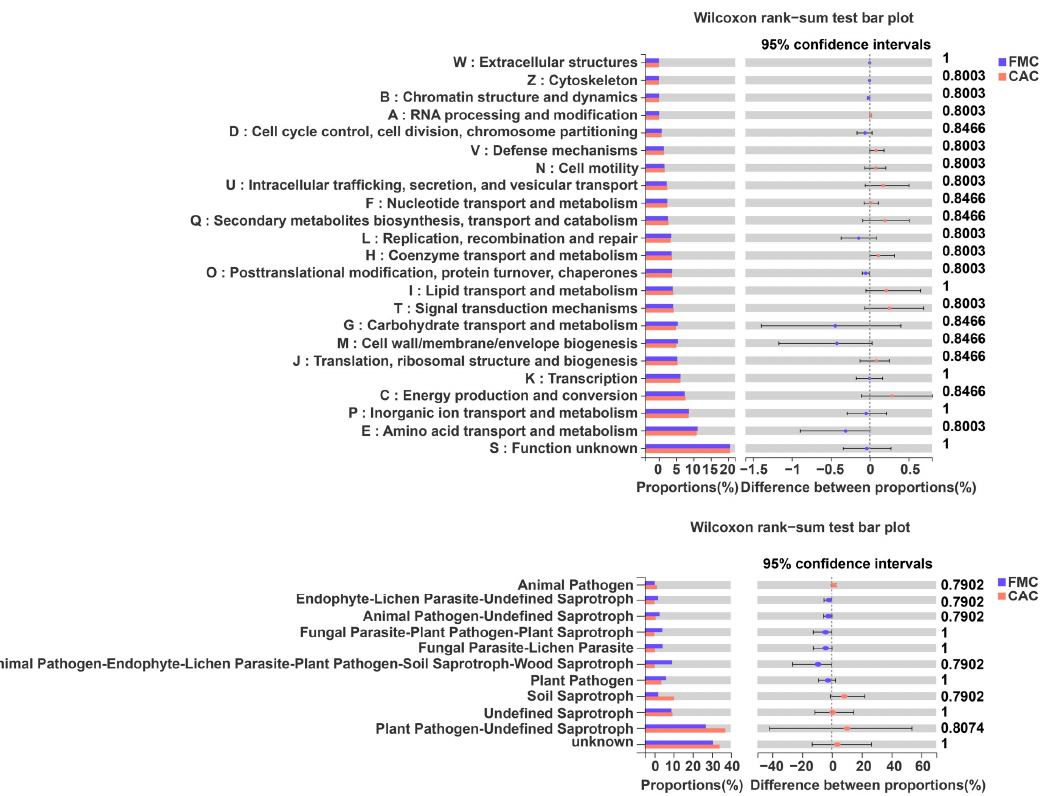
Figure 6. Endophytic bacterial community phenotypes from FMC and CAC treatments identified by BugBase-predicted analysis. FMC—fully mechanized cultivation; CAC—conventional artificial cultivation.